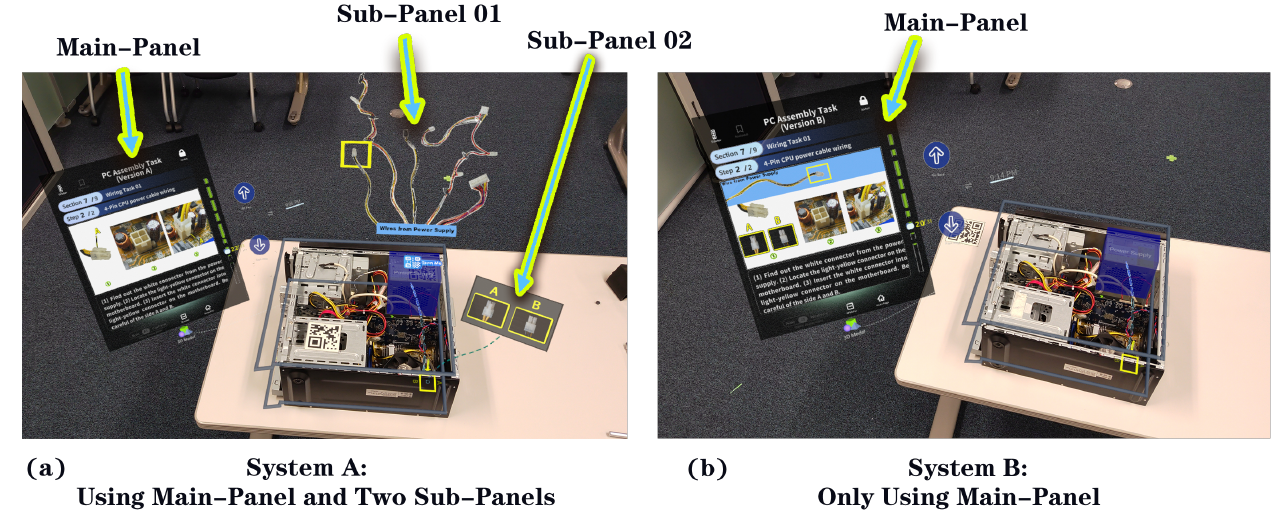
Figure 33. The difference between the two systems in PC assembly task. ( a ) In System A, multiple sub-panels can be used in conjunction with the main-panel. ( b ) In System B, all text, images, and videos are displayed in the main-panel (3D model still